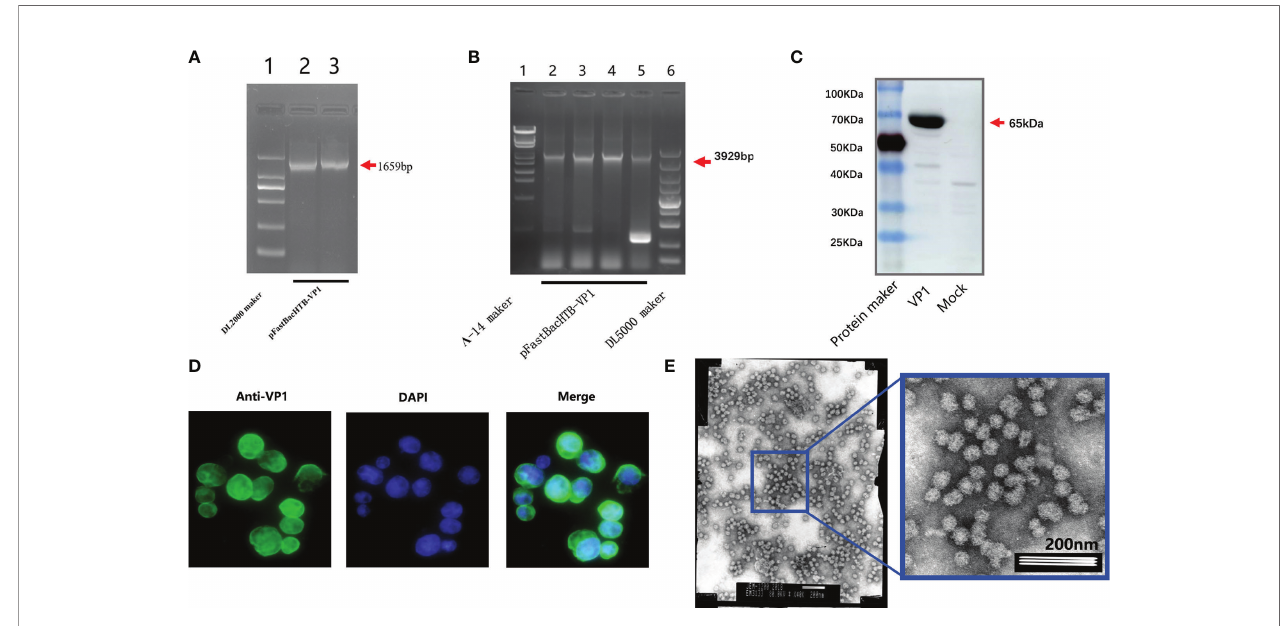
FIGURE 1 | Identi fi cation of virus-like particles. PCR ampli fi cation of the recombinant plasmid pFastBac-HTB-VP1 using VP1 speci fi c primers (A) . PCR ampli fi cation the pFastBac-HTB-VP1 showing a recombinant rod-shaped plasmid using pUC/M13F and pUC/M13R primers (B) . Western blot analysis detecting norovirus VP1 protein in SF9 cells infected with pFastBac-HTB-VP1 or a mock control (C) . The cells from (C) were analyzed by indirect immuno fl uorescence staining against VP1 (green) or after DAPI staining to reveal cell nuclei (blue) (D) . Electron microscopic observation of SF9 cells after recombinant baculovirus infection revealing abundant VLPs (E)